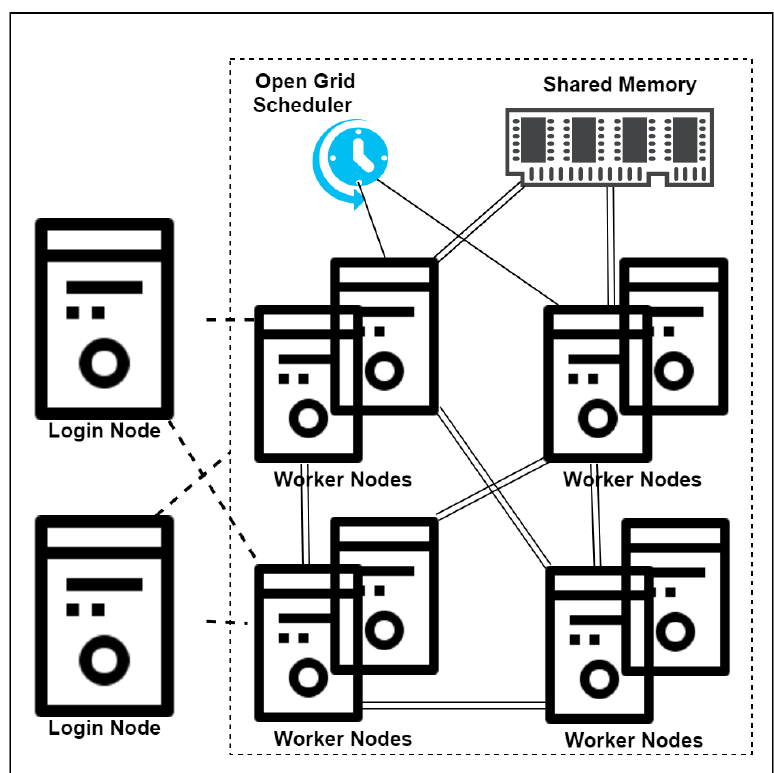
Figure 4. Overview of Eddie architecture. Login nodes lets users start an interactive session or submit batch jobs. The submitted jobs run on worker nodes connected through 10 Gbps Ethernet network depicted by double